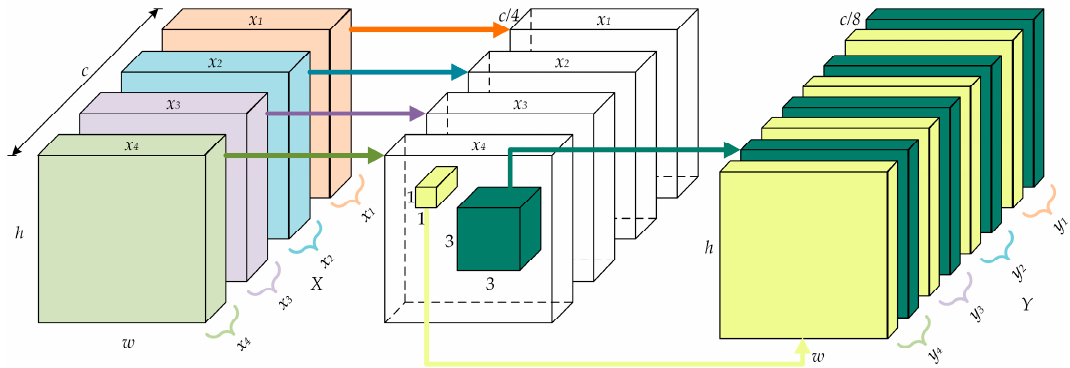
Figure 4. The architecture of the OIM. The input feature map X is split into four parts, denoted by x 1 ~ x 4 . The yellow block denotes the 1 × 1 convolution layer, and the green one indicates the 3 × 3 convolution layer. The y 1 ~ y 4 indicates output feature splits that are merged into Y .